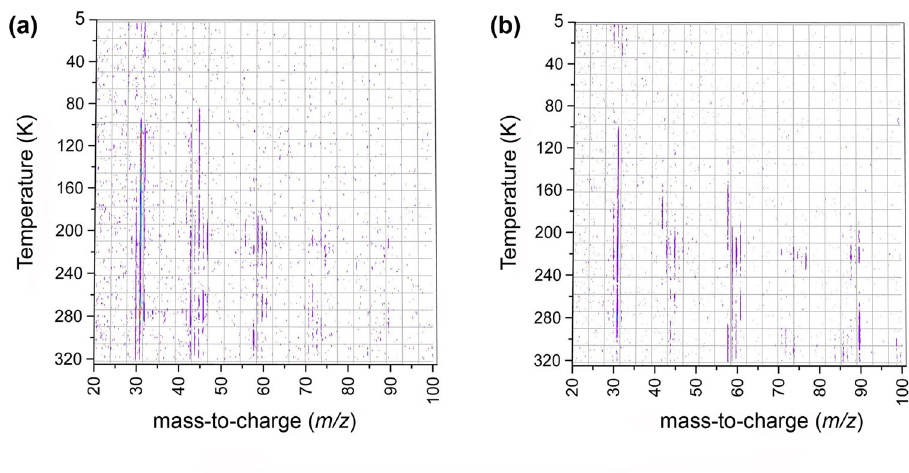
Fig. 3 PI-ReTOF mass spectra. Measured as a function of temperature during the temperature program desorption phase of irradiated methylamine (CH 3 NH 2 )-oxygen (O 2 ) ice mixtures at photon energies of ( a ) 9.50 and ( b ) 9.10 eV. The dark purple colored lines indicate ion counts. Source data are provided as a Source Data fi le.